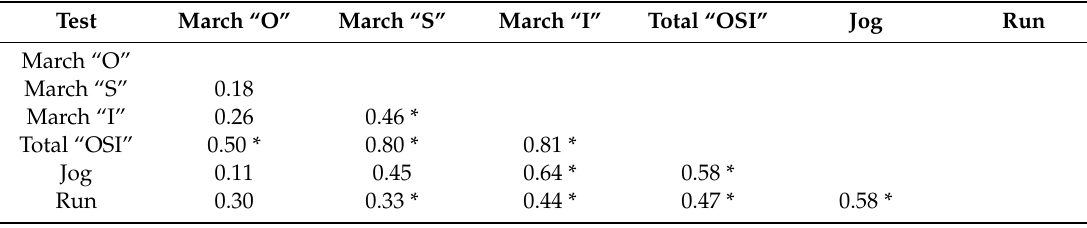
Table 5. Spearman’s Rank correlation of the trial results for hurdle clearance with the right leg at marching, jogging, and running